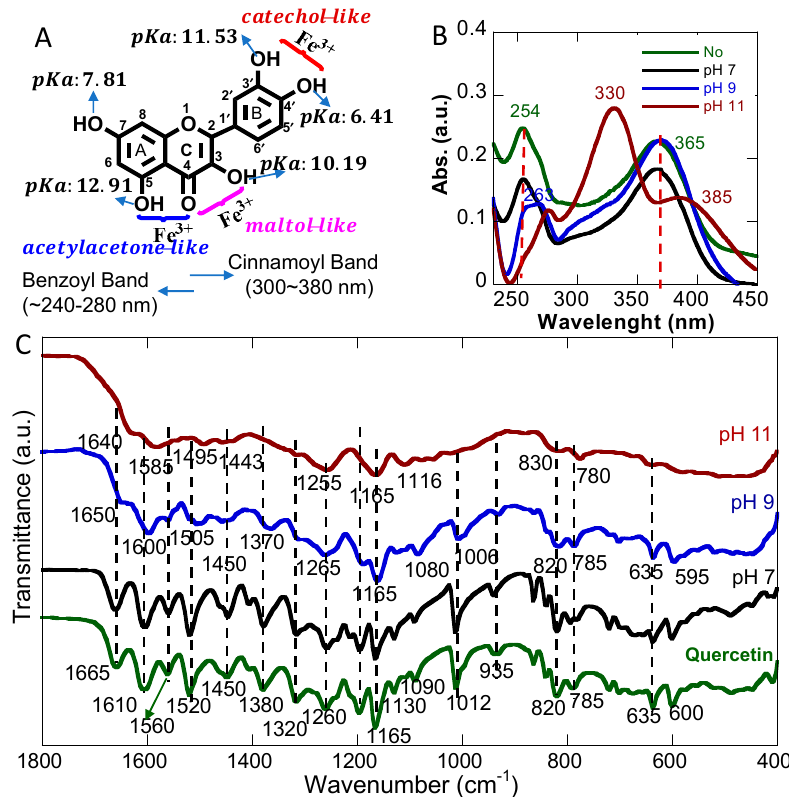
Figure 1. ( A ) Structure of quercetin with typical pKa values of hydroxyl groups and metal coordi- nation sites along with typical absorbance, ( B ) UV-Vis absorption spectra of Q solution at different pHs compared with no pH adjustment, and ( C ) FTIR spectra of Q at different pHs compared with no pH adjustment.